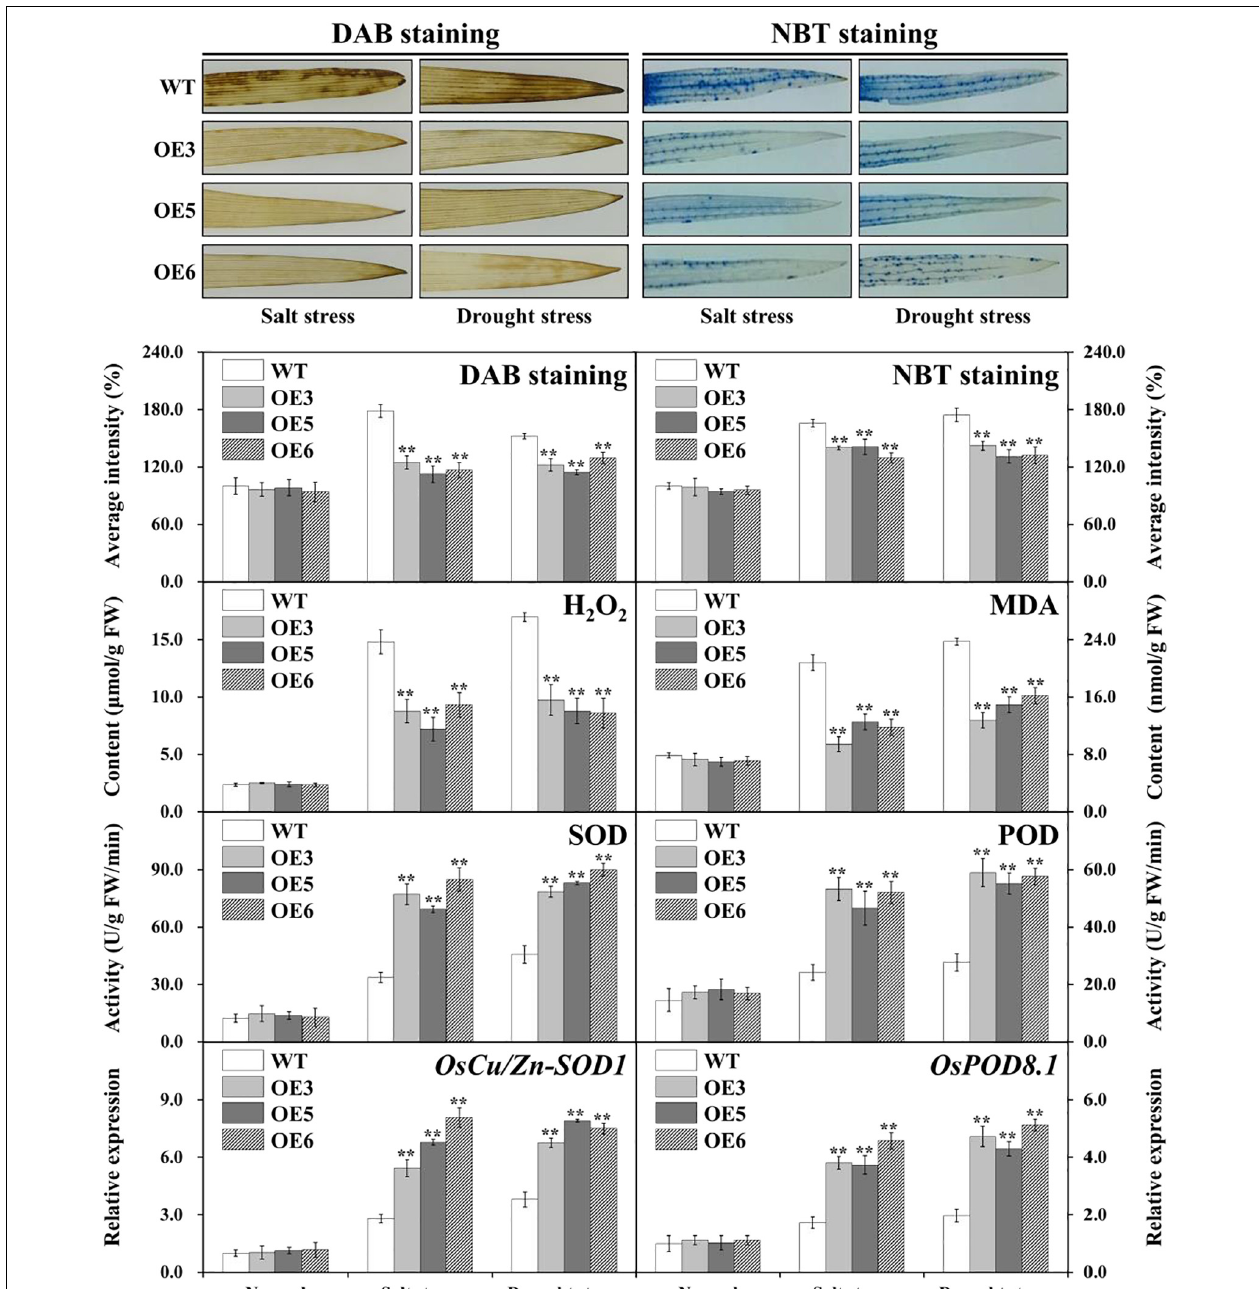
FIGURE 8 | Decreased ROS damage in the overexpressing OsIAA18 and WT plants. DAB and NBT staining for H 2 O 2 and O 2 - , H 2 O 2 and MDA content, SOD and POD activities, expression of OsCu/Zn-SOD1 and OsPOD8.1 genes in the leaves of transgenic plants and WT under salt and drought stresses. Data are presented as means ± SE ( n = 3). The values of * and ** indicate a significant difference from that of WT at P < 0.05 and < 0.01, respectively, by Student’s t